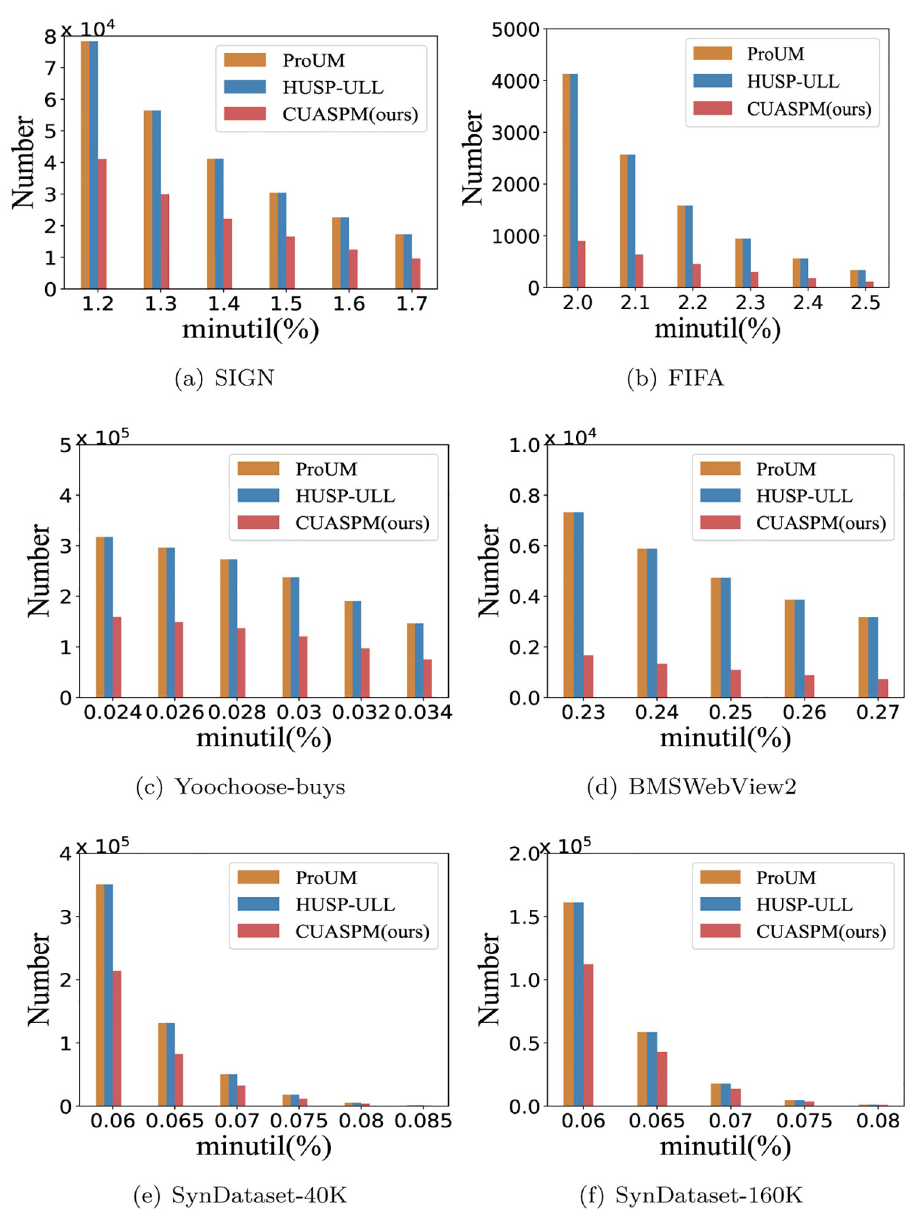
Fig 6. The number of pattern under the various minutil thresholds. (a) SIGN, (b) FIFA, (c) Yoochoose-buys, (d) BMSWebView2, (e) SynDataset-40K, and (f) SynDataset-160K.